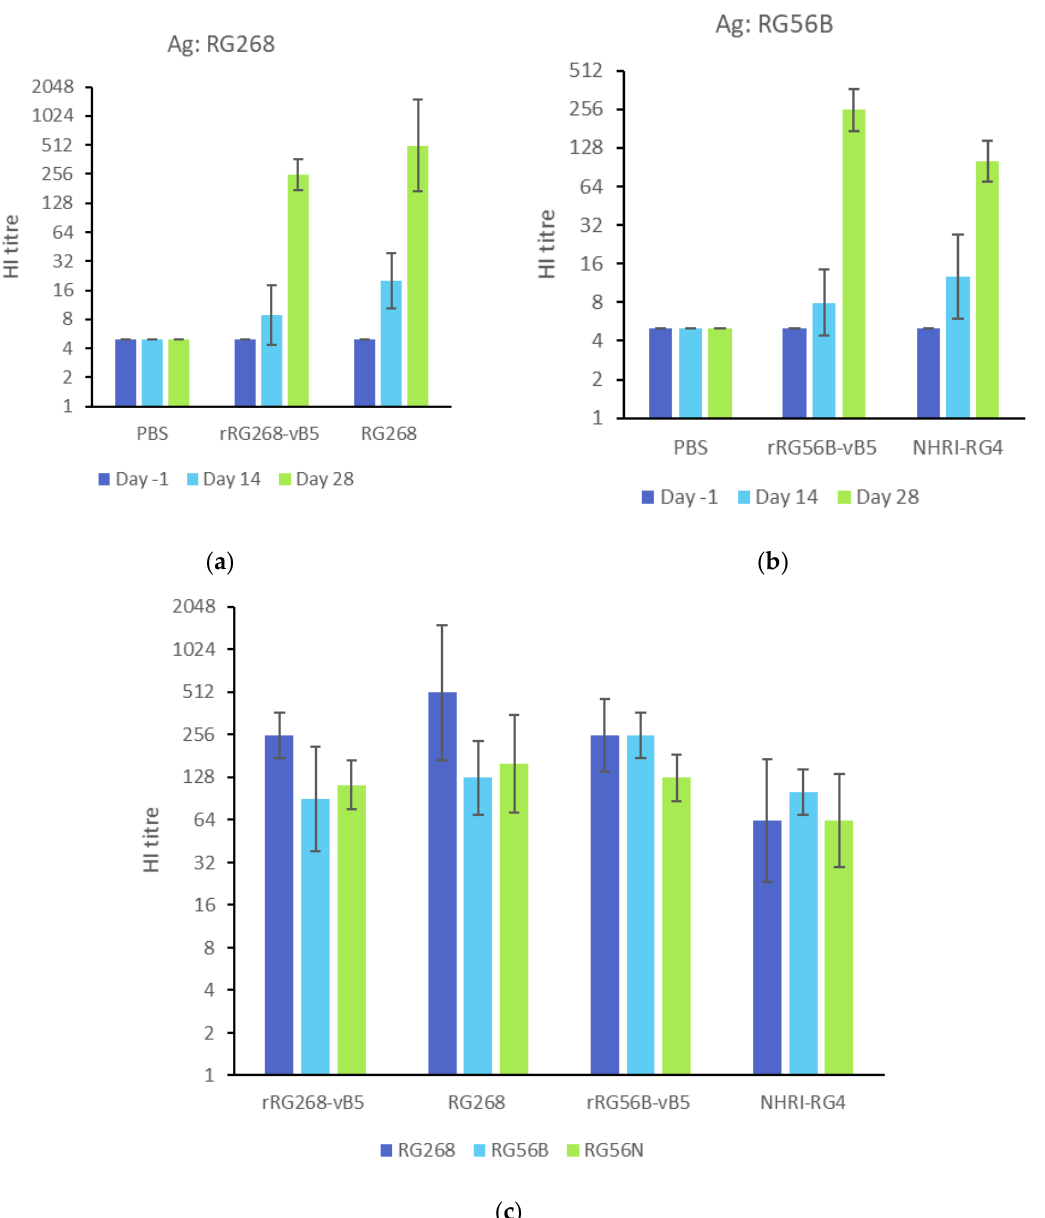
Figure 6. Immunogenicity of rRG268-vB5 and rRG56B-vB5 in mice. ( a ) Sera from rRG268-vB5 immunized mice were used to measure HI titers against homologous antigens (RG268). ( b ) Sera from rRG56B-vB5 immunized mice were used to measure HI titers against homologous antigens (RG56B). NHRI-RG4: MDCK cell-derived CVV carrying HA and NA genes from A/Hong Kong/125/2017. ( c ) Sera from immunized mice were used to measure against heterologous antigens (RG268, RG56B, RG56N: A/Guangdong/17SF003/2016). The error bar represents the 95% of confidence interval.